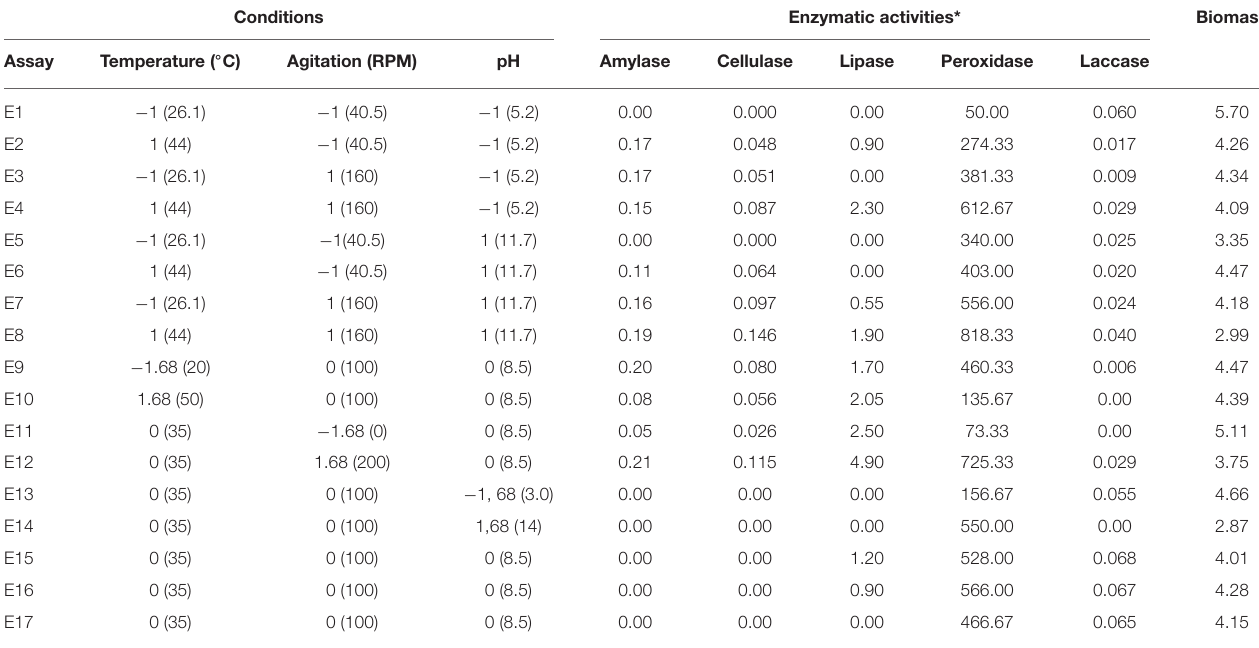
TABLE 4 | Matrix of experimental design central composite rotatable design (CCRD) 2 3 (coded and real values) and respective answers in terms of enzymatic and biomass production. Conditions Enzymatic activities* Biomass Assay Amylase Cellulase Lipase Peroxidase